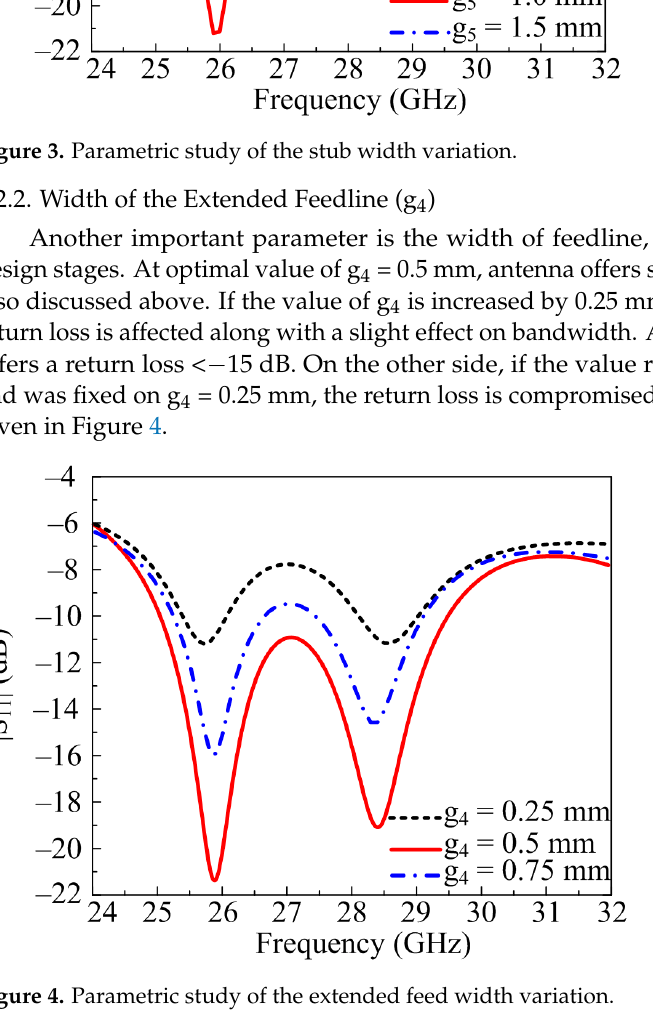
Figure 3. Parametric study of the stub width variation.